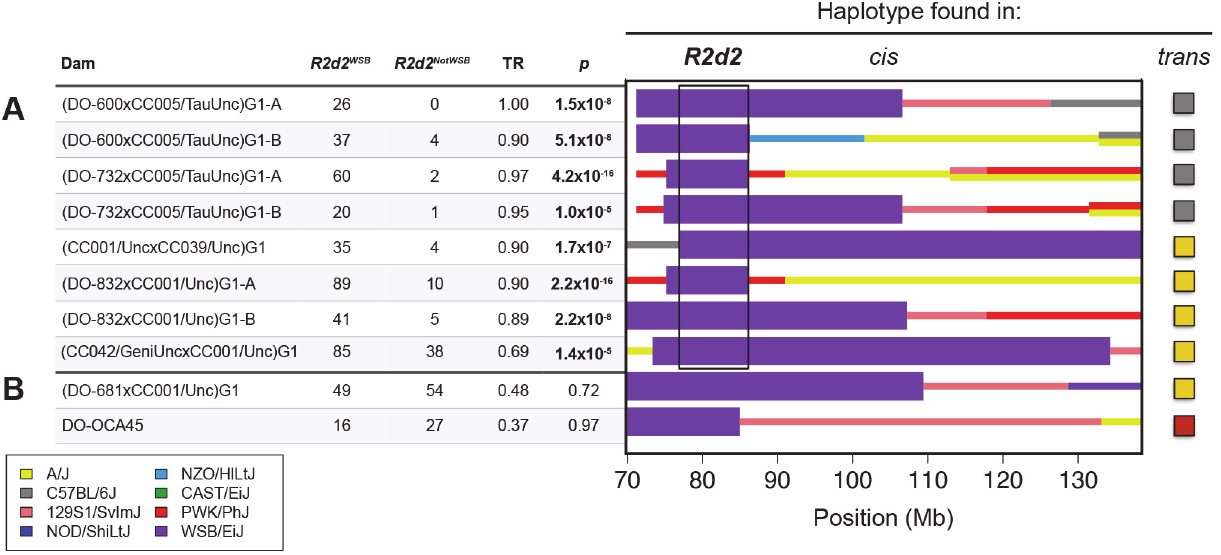
Figure 1. R2d maps to a 9.3 Mb candidate interval. CC and DO mice were crossed to generate G1 dams, which were then crossed to FVB/NJ sires to determine the TR in their progeny. Each G1 dam carries a chromosome that is recombinant for the WSB/EiJ haplotype (shown under the heading cis ) and a non-WSB/EiJ chromosome (the haplotype on the homologue is shown at far right under the heading trans ). Dams with the same diplotype in the central region of Chr 2 were grouped together to define ten unique diplotypes. The aggregate number of WSB/EiJ and non-WSB/EiJ alleles transmitted by dams of each diplotype are shown for dams A) with TRD and B) without TRD. Significance of TR deviation from Mendelian expectation of 0.5 was computed using one-sided binomial exact test ( p -value). The contribution from the eight founders of the CC and DO are shown in different colors. Thick purple bars indicate the extent of WSB/EiJ contributions, and thin bars indicate the extent of contributions from all other strains. The black box indicates the boundaries of the R2d candidate interval as determined by the region that is WSB/EiJ in all dams with